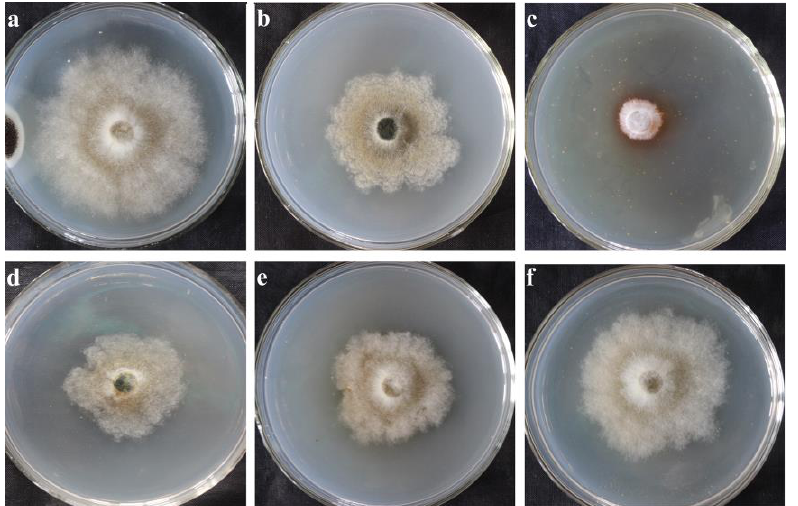
Figure 1. Inhibitory effect of the supernatant of Xenorhabdus bovienii on Fusarium solani (NK-NH1) incubated for different time. Incubated at 28 °C for 5 days, n = 3. ( a ) TSY medium; ( b ) 1-day incubation time; ( c ) 2 day incubation time; ( d ) 3-day incubation time; ( e ) 4-day incubation time; ( f ) 5-day incubation time.